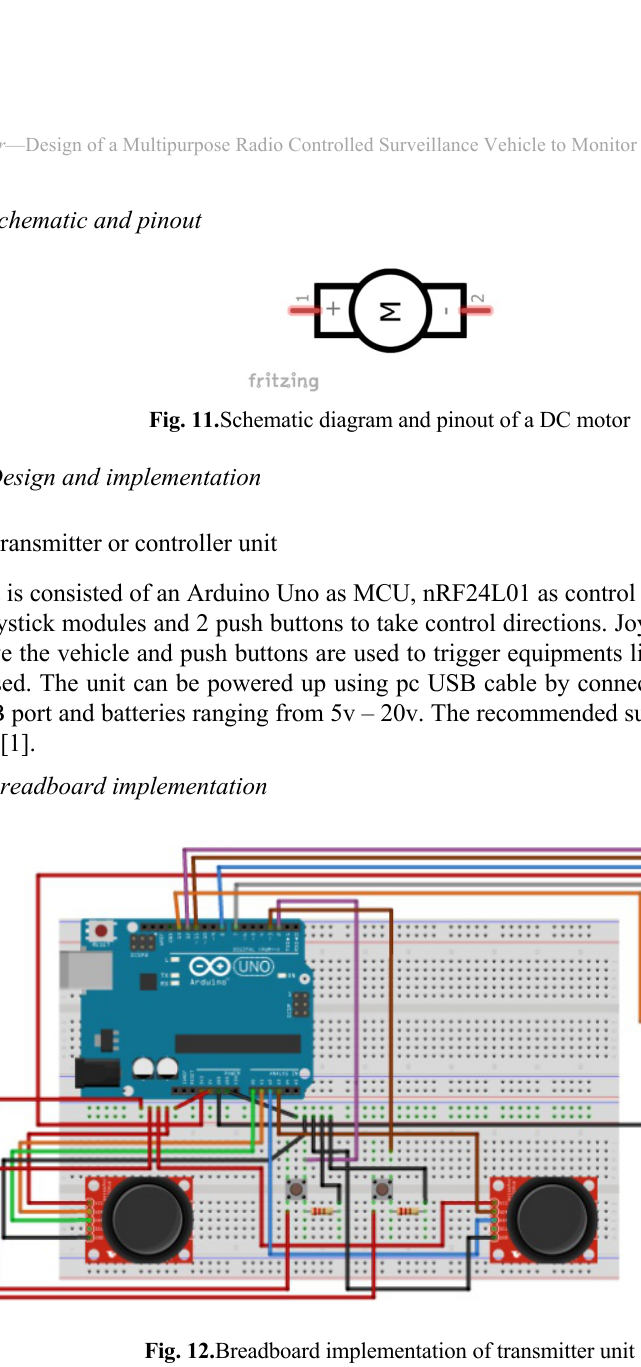
Fig. 12. Breadboard implementation of transmitter